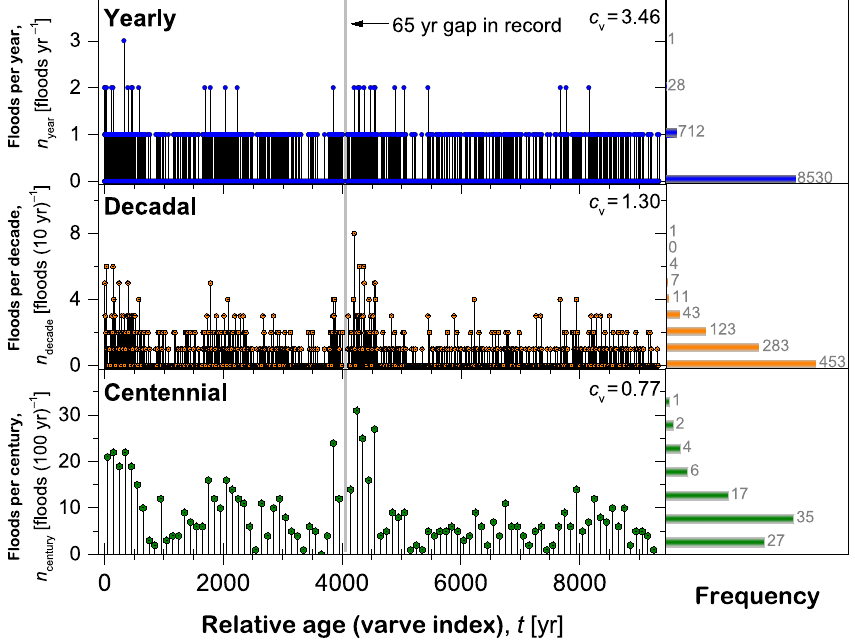
Figure 3. Temporal succession, histograms, and autocorrelation of the detrital layers of the 9336-year Piànico–Sèllere, Italy, palaeoflood record (data available at Mangili et al., 2017). The number of observed detrital (flood) layers per year (blue dots, 0 ≤ n year ≤ 3 floods yr − 1 ) , decade (orange dots, 0 ≤ n decade ≤ 8 floods decade − 1 ) , and century (green dots, 0 ≤ n century ≤ 31 floods century − 1 ) are presented over the 9336 years of the record examined. The x -axis represents relative age, with t = 1 year the most recent varve and increasing values indicating further back in time. The grey bar represents a sediment gap of 65 years (leaving 9271 years of the record examined over the 9336 years). In addition, for each time resolution is given (upper right) the coefficient of variation c v = σ/µ , where σ is the standard deviation and µ is the mean of the given time series. Shown to the right of each palaeoflood time series is the respective histogram of the number of floods per year (blue bars), decade (orange bars), and century (green